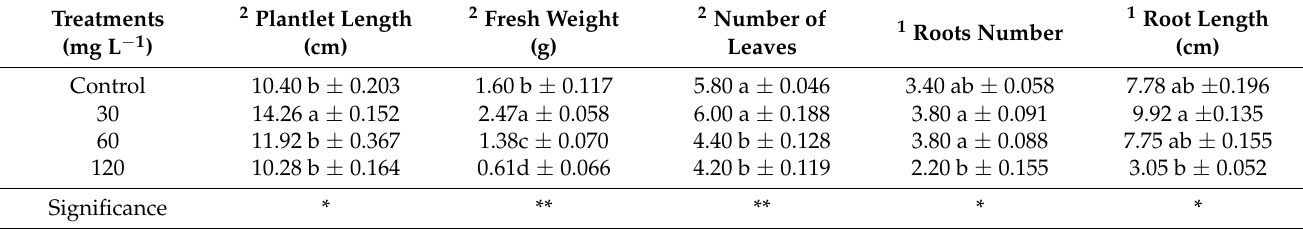
Each treatment was the mean of five replicates (jars) and each replicate contained one shoot. Values are the mean ± SE and values followed by the same letters in the same column were not significantly different by 1 Kruskal–Wallis Test and 2 Duncan’s test at 0.05 level. * means Significant, ** means high significant. NS means not significant at p ≤ 0.05. Control = 0.025 mg L − 1 represents the concentration of CuSO 4 5H 2 O in MS medium (without copper sulphate